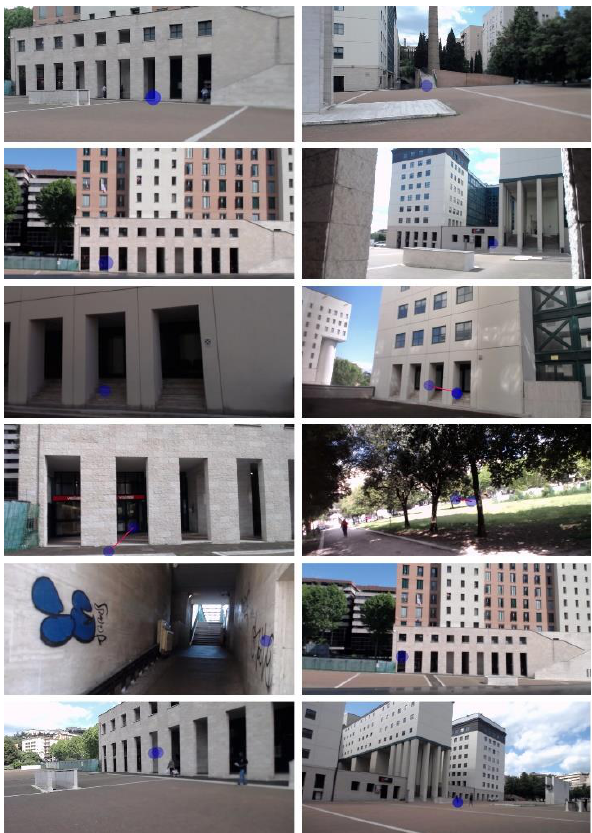
Figure 5– Original project of Aldo Rossi’s